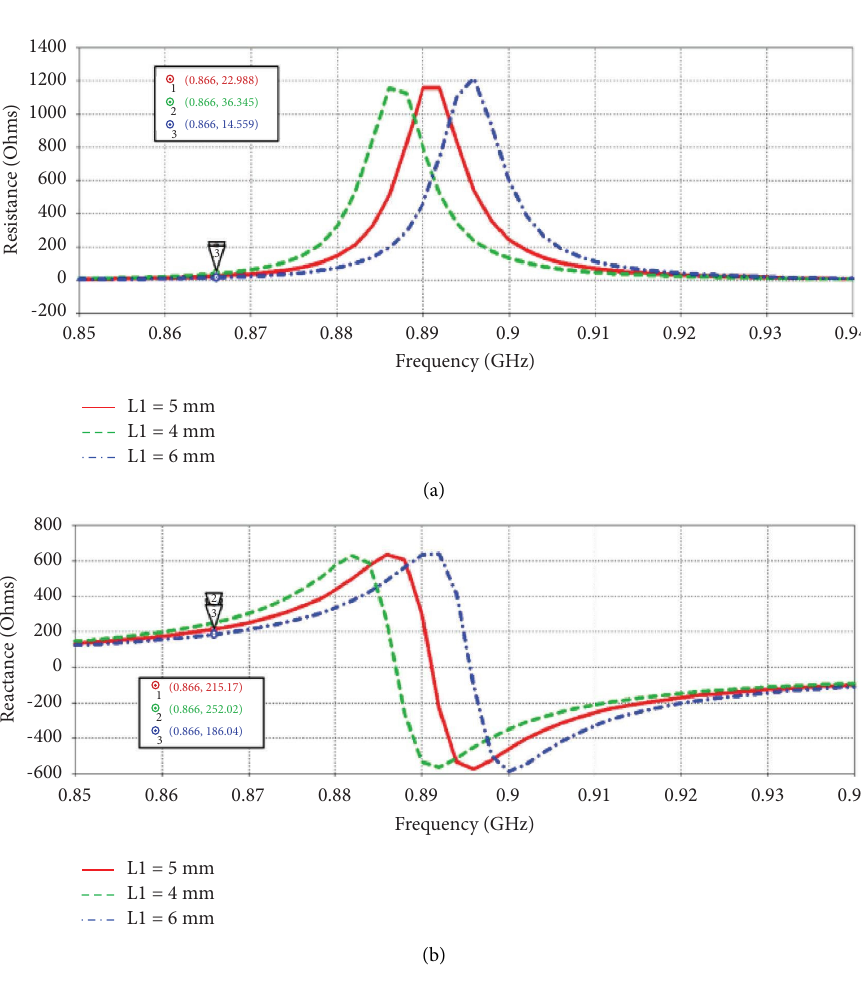
Figure 5: Tag’s (a) resistance and (b) reactance variation with “ L